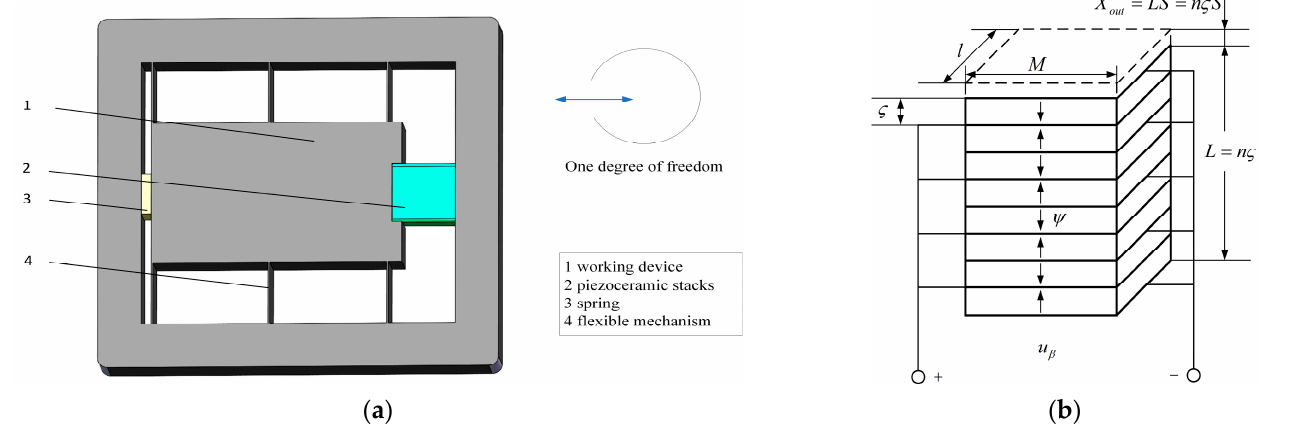
Figure 1. Three-dimensional schematic: ( a ) one-degree-of-freedom nanopositioning platform; ( b ) piezoelectric ceramic stacking.